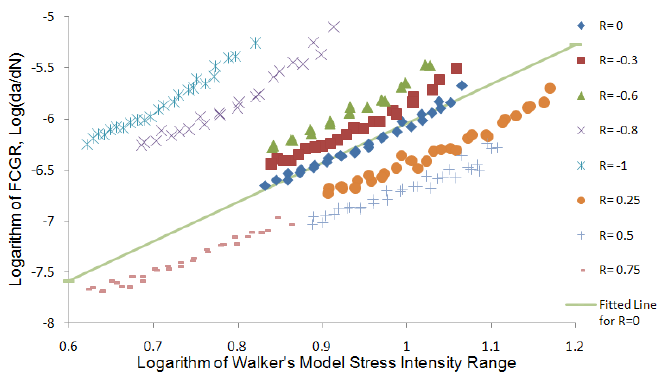
Figure 34. Experimental data presented by the Walker model